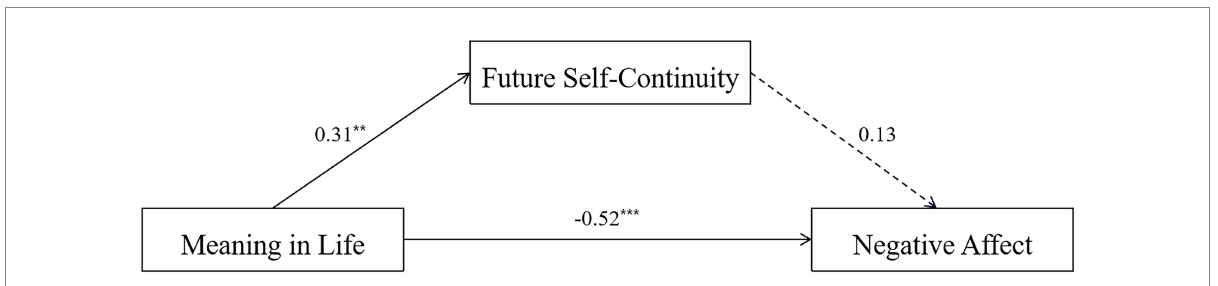
FIGURE 2 Mediational pathways of MIL on NA. ** p < 0.01, *** p <